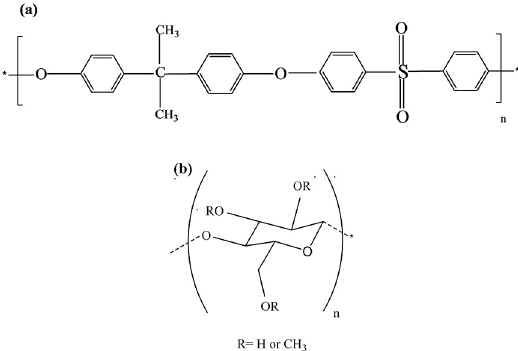
Figure 1: The molecular formulas: (a) polysulfone and (b) methylcellulose.